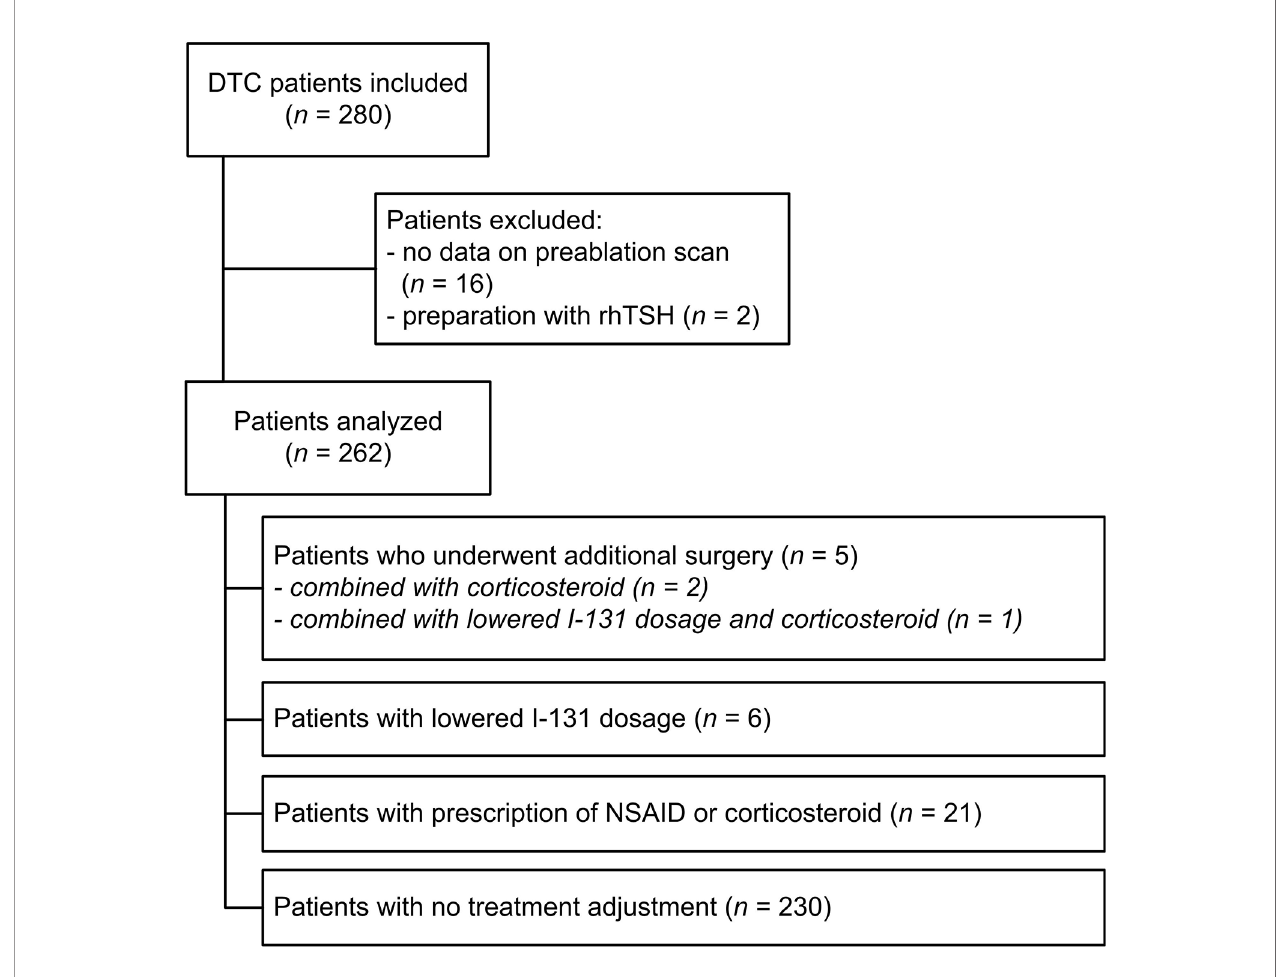
FIGURE 1 | Flowchart of inclusion and clinical management. DTC, differentiated thyroid carcinoma; NSAID, non-steroidal anti-in fl ammatory drugs; rhTSH, recombinant human